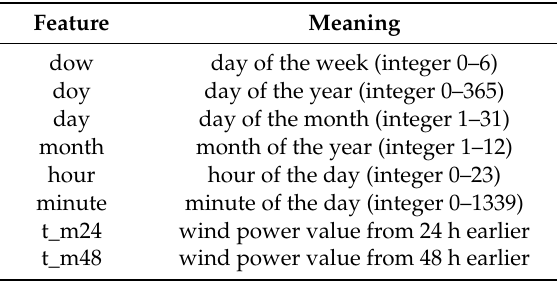
Table 1. Meaning of di ff erent time features.